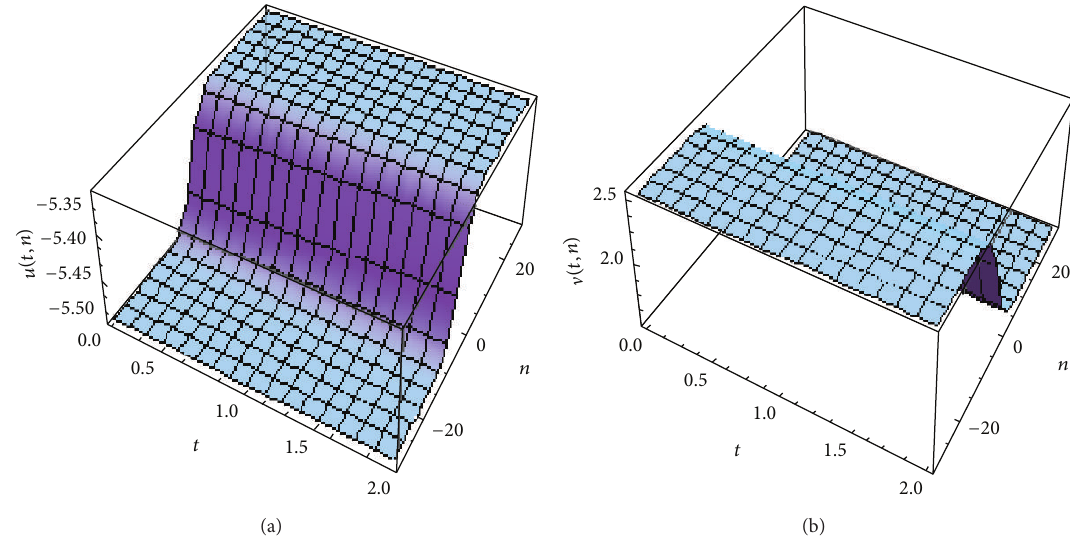
Figure 5: The 4th-order approximate solution (46) and (47), respectively, at ℎ|